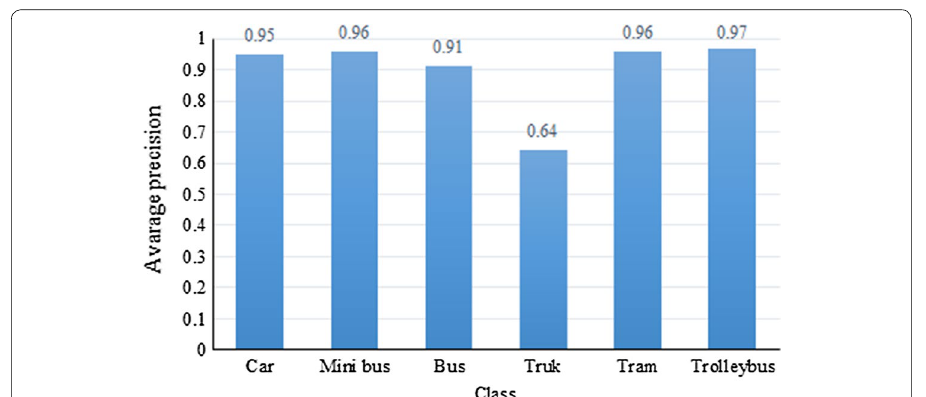
Fig. 9 Average precision values for classes